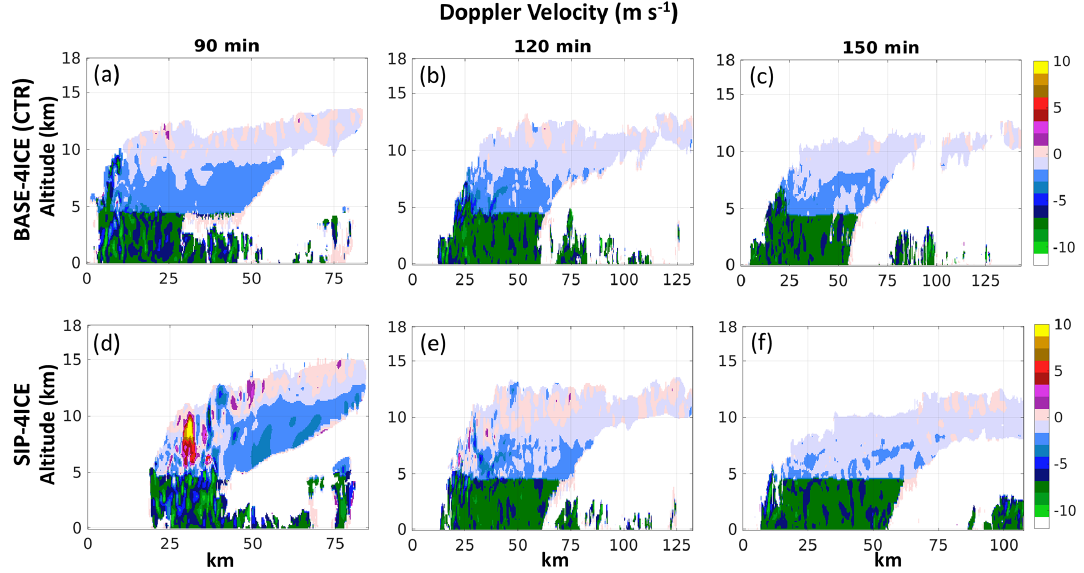
Figure 15. Simulated Doppler speed for the cross sections indicated by the black lines in Fig. 10.